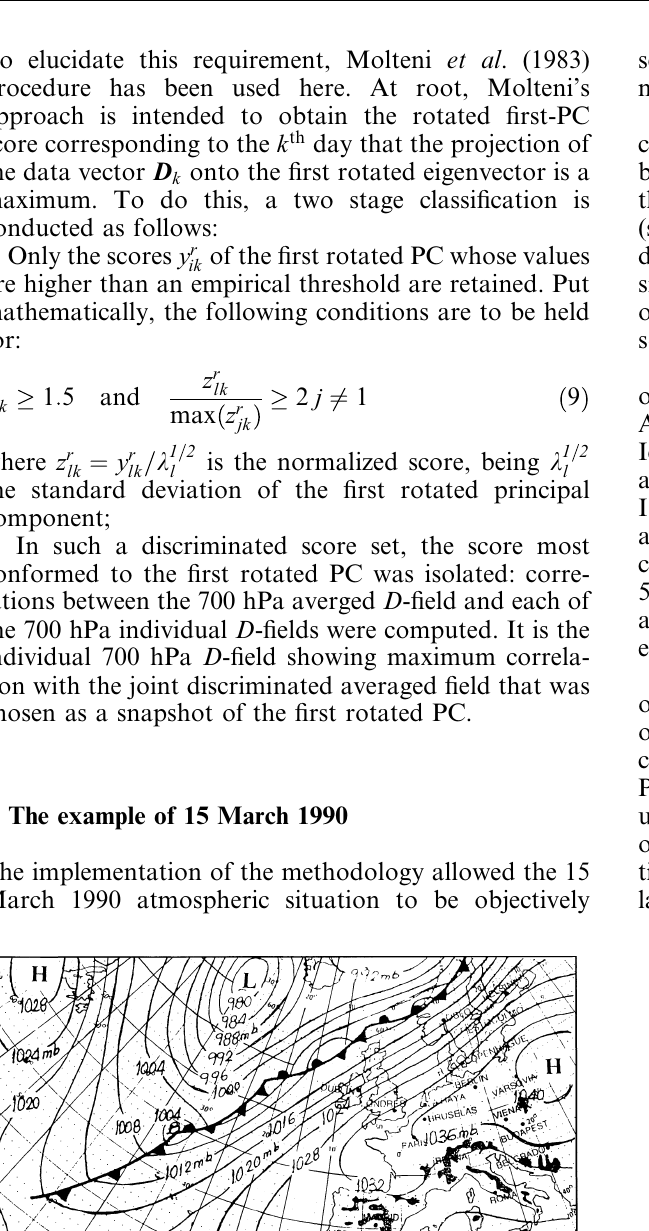
Table 2. Variances (cid:107) i and cumulative variance ratios (percentages) of the first three PCs 1st PC 2nd PC 3rd PC Nonrotated Rotated Nonrotated Rotated Nonrotated Rotated Variance explained